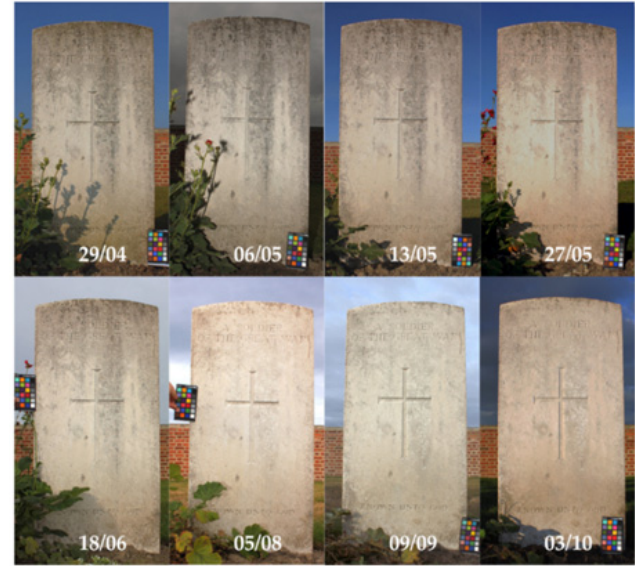
Figure 6. Evolution of grey-black biofilm in streaks (Site A).